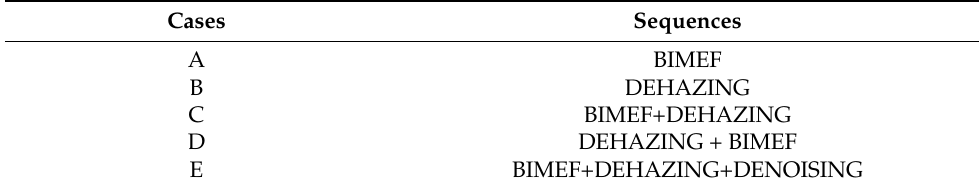
Table 2. List of the analyzed cases to determine the best algorithm sequence for the proposed method.